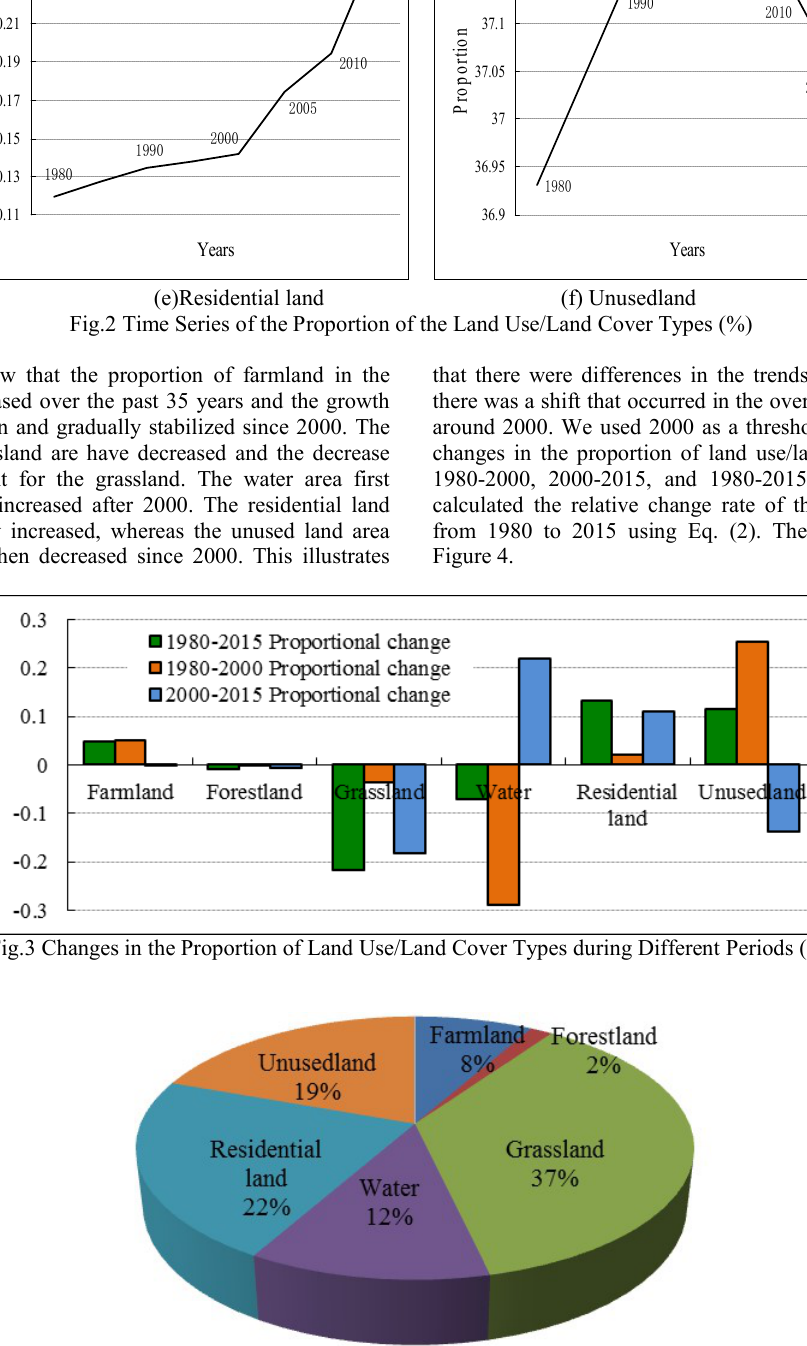
Fig.4 Relative Change Rate of the Land Use/Land